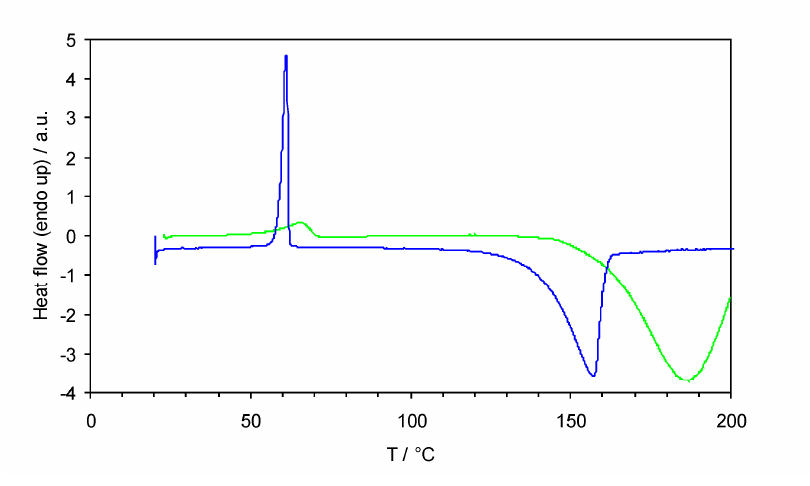
Figure 3. Differential Scanning Calorimetry (DSC) curves of 1 (blue) and 2 (green) showing the endothermic melting events and the exothermic